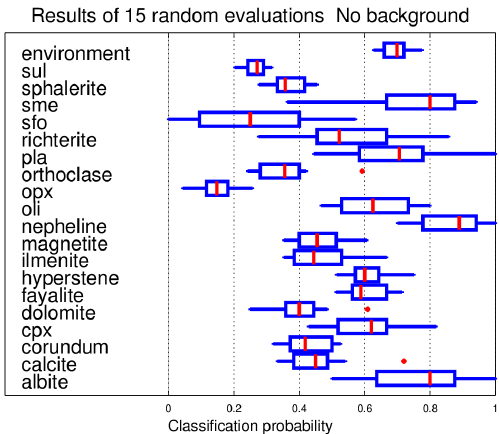
Figure 6. Cross validation accuracies showing the Cohen κ value computed for the data projected to a 100 dimensional space using random projections. For this case, background is regarded as those visually identified spectra surrounding measured minerals, marked as “environment”.